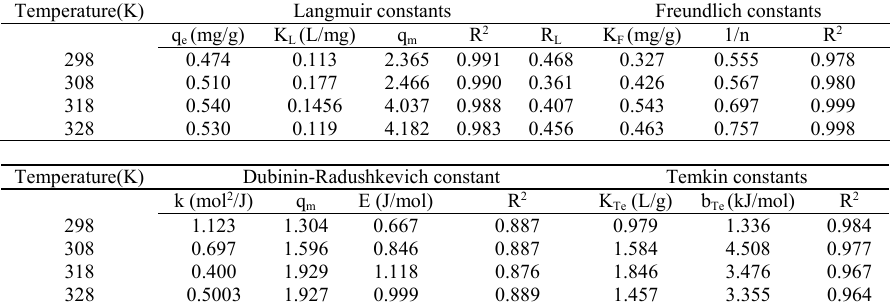
Table 4 Langmuir, Freundlich, Dubinin-Radushkevich and Temkin isotherms parameters. Table 4. Langmuir, Freundlich, Dubinin-Radushkevich and Temkin isotherms Temperature(K) Langmuir constants